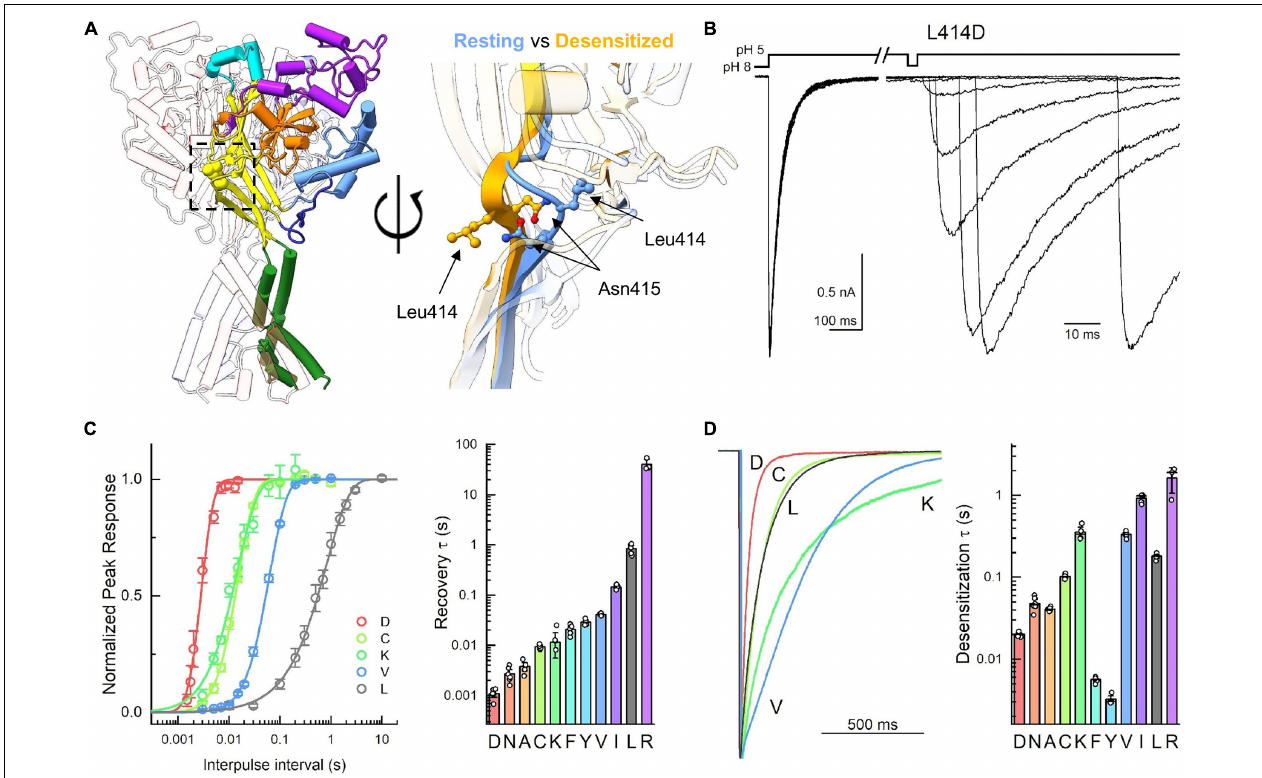
FIGURE 1 | Mutations to Leu414 have substantial impact on channel kinetics. ( A , left) Trimeric structure of the resting state with individual domains colored (PDB: 6VTL). ( A , right) Zoom in of the β 11-12 linker in overlay of resting (6VTL, blue) and desensitized states (6VTK, orange). (B) Example outside-out patch recordings of L414D during recovery from desensitization protocol. Note the change in time scale in the example traces. (C) Summary recovery time course (left) and time constants (right) for Leu414 mutant panel from this and previous work. (D) Example traces (left) and summary of time constants (right) for desensitization decays of Leu414 mutant panel. Symbols represent individual patches and error bars are SEM. Differences in both desensitization and recovery kinetics for all mutations were statistically significant from wild type. Some data reproduced from Rook et al. (2020) under Creative Commons Attribution License